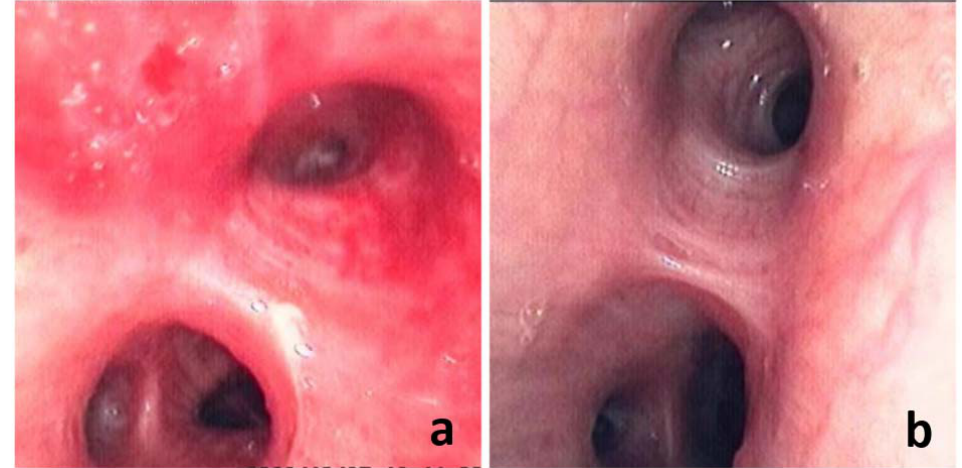
Figure 1. Bronchoscopic images of two patients with TBI. ( a ) 71 ‐ year ‐ old male, GCS score was 5, was diagnosed with HAP on the third day and without folic acid treatment after admission. The bronchoscopic image was taken 19 days after the patient’s admission. The image showed that the patient had significant damage to the tracheal mucosa. ( b ) 69 ‐ year ‐ old male, GCS score was 5, was diagnosed with HAP on the third day and with folic acid treatment after admission. The bronchoscopic image was taken 16 days after the patient’s admission. The image showed that the patient’s tracheal mucosa was